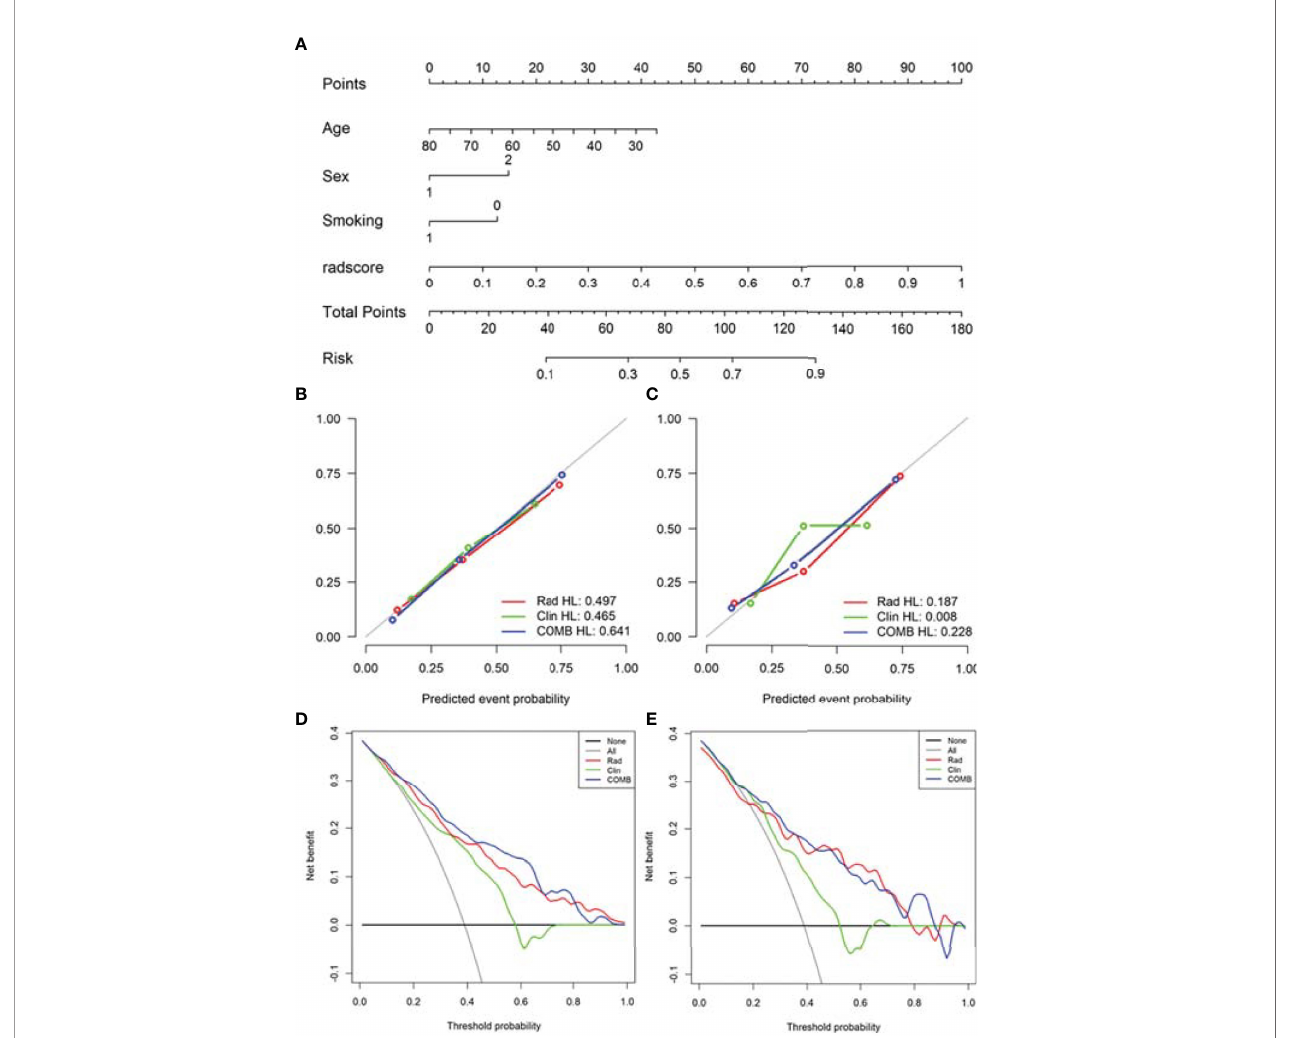
FIGURE 4 | Nomogram was used to identify Del-19 mutation and wild-type. (A) Construct a nomogram in the training set based on the combined model. (B, C) Calibration curve of the combined model in the training (B) and validation (C) sets. The x-axis represents the use of the combined model to predict the risk of Del-19 mutation. The y-axis represents the actual Del-19 mutation rate. The green, red, and blue lines represent the distinguishing ability of the clinical, radiomics, and combined models, respectively, while the gray diagonal line represents the ideal evaluation of the ideal model. The closer the fi t to the diagonal line indicates the better discrimination ability. (D, E) Decision curve analysis for the combined model in the training (D) and validation (E) sets. The x-axis shows the threshold probability, and the y-axis measures the net bene fi t. The gray line represents all patients with Del-19 mutation, and the black line represents all patients without Del- 19 mutation. The green, red, and blue lines represent the clinical, radiomics, and combined models,